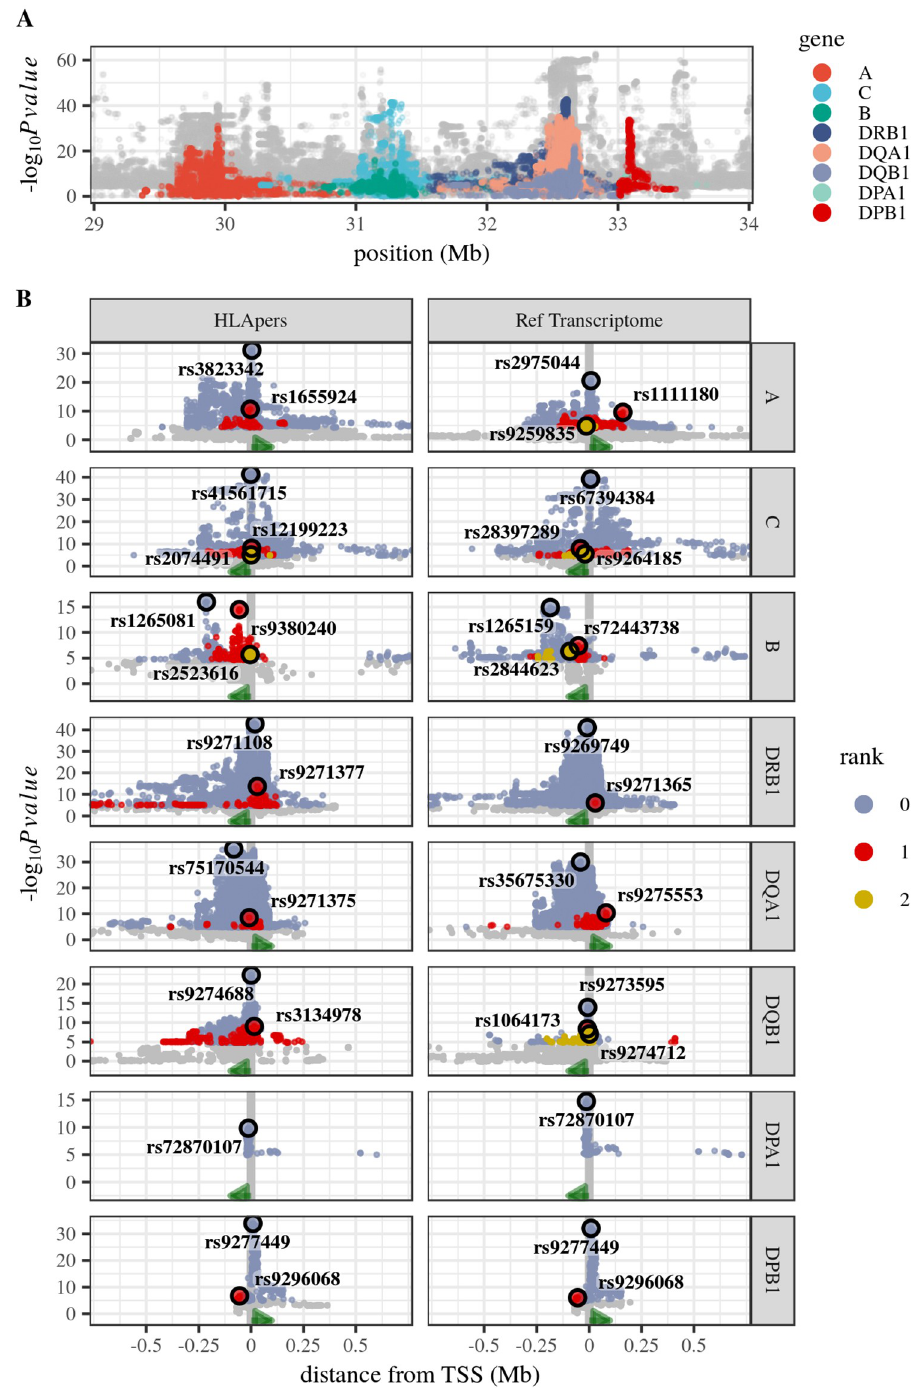
Fig 5. eQTLs for HLA loci. A: Distribution of p-values for the association between genotypic and expression variation along the HLA region, colored by gene. B: Distribution of p-values around the transcription start site (TSS, vertical line at x = 0), for eQTLs mapped with HLApers or reference transcriptome pipelines. Points are colored according to the rank of association (with gray for non-significant associations at an FDR of 5%). The best eQTL of each rank is circled in black. Green arrows indicate the orientation of transcription. There was no eQTL mapped for HLA-DRA .